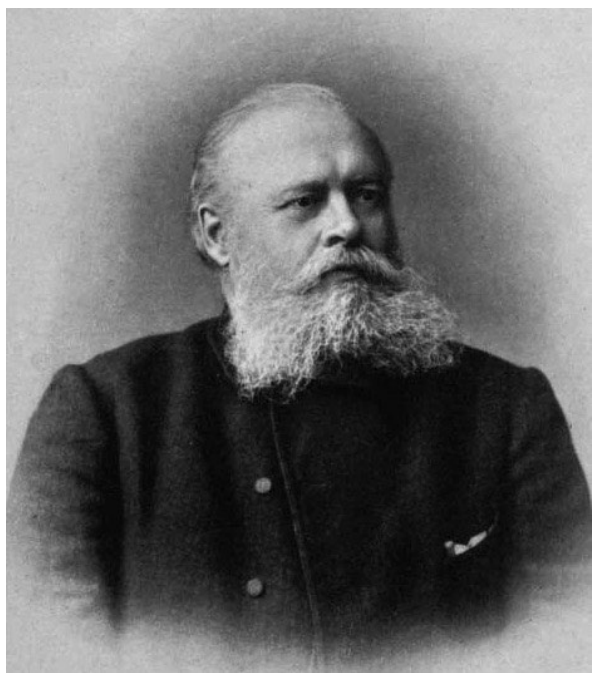
Figure 1. Vladimir Vasilyevich Markovnikov (1838-1904) (Public domain, from reference